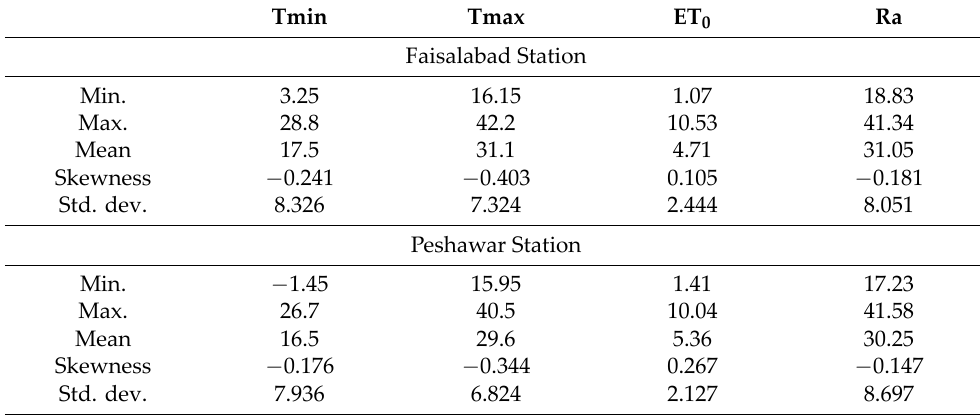
Table 1. The statistical parameters of the applied data.